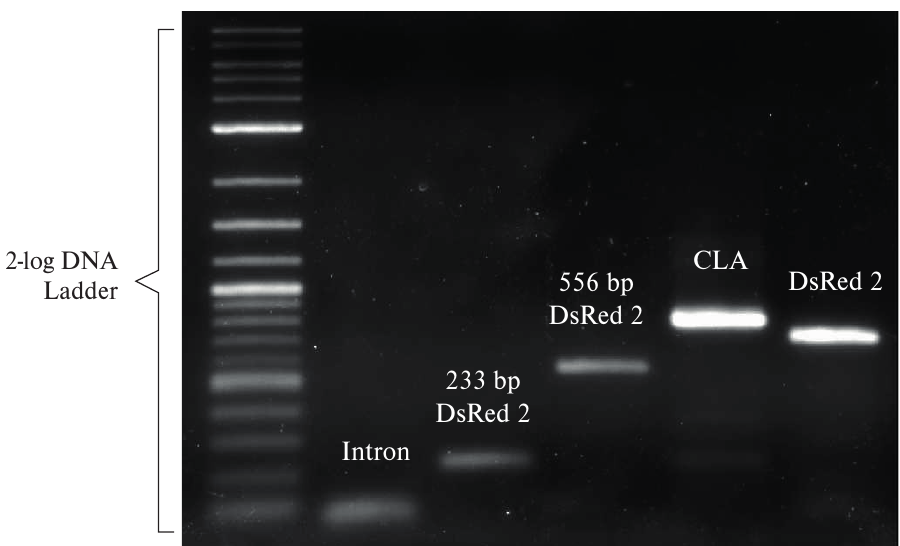
Fig. 1. Directed assembly of intron between two fragments of DsRed2 gene. Lane 1 2-log DNA ladder; Lane 2 PCR amplification of 79 bp intron; Lane 3 PCR amplification of 233 bp fragment of DsRed2 gene; Lane 4 PCR amplification of 556 bp fragment of DsRed2 gene; Lane 5 PCR amplification of 763 bp CLA product; Lane 6 PCR amplification of DsRed2